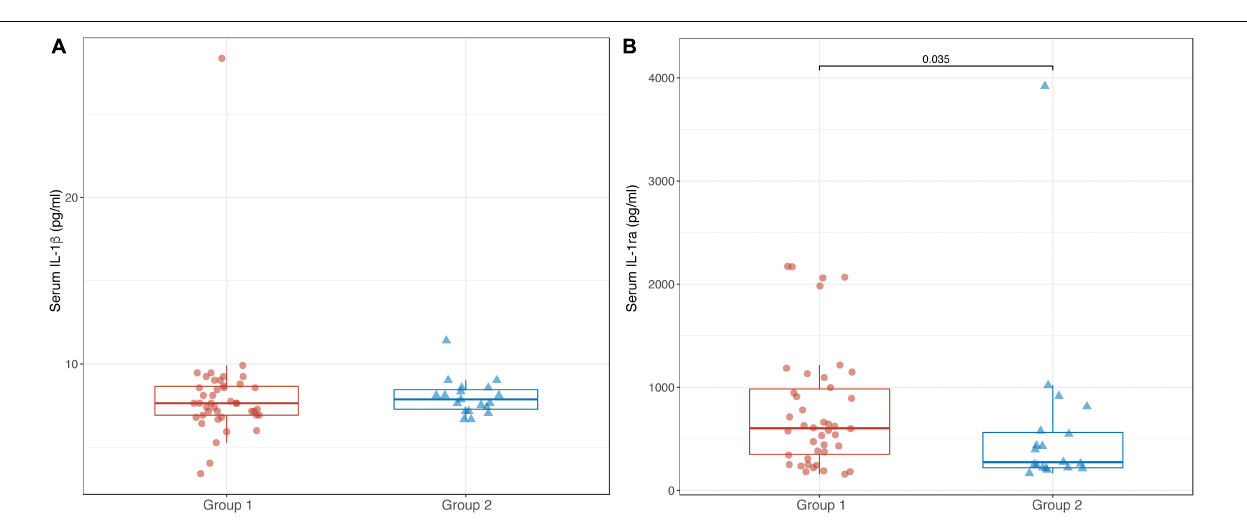
FIGURE 3 | Box-plots showing serum levels of IL-1 β (A) and IL-1ra (B) in Groups 1 and 2. Boxes are defined by Q1, median (bold line) and Q3. Whiskers reach the minimum and the maximum of the distribution except for the presence of outliers, defined as data points below Q1 – 1.5 × IQR or above Q3 + 1.5 × IQR. To avoid overlapping a small amount of horizontal jitter was added. Q1, first quartile; Q3, third quartile; IQR = Q3 –